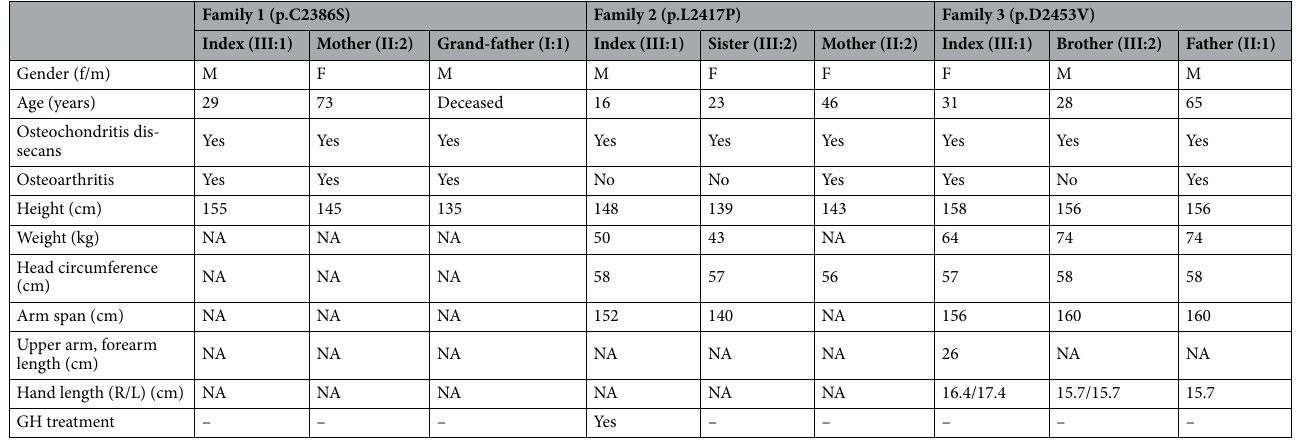
Table 2. Phenotype baseline data of individuals included in study. NA not